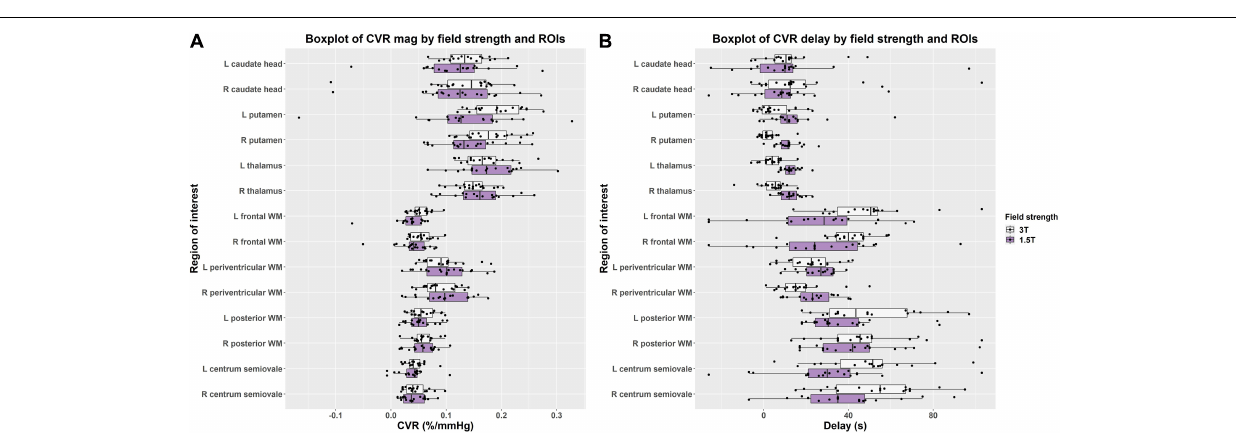
FIGURE 4 | Boxplots comparing of (A) CVR magnitude (mag) and (B) delay values in subcortical gray and white matter regions at 1.5 and 3T (L = left, R =